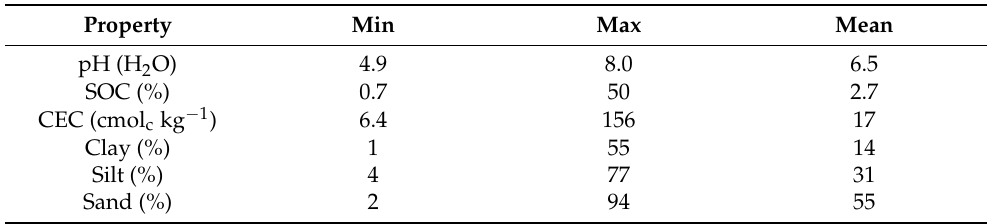
Table 1. Descriptive statistics on soil pH; soil organic carbon content (SOC); cation exchange capacity (CEC); and clay, silt, and sand content in 332 topsoil samples (0–20 cm depth) from agricultural soils in